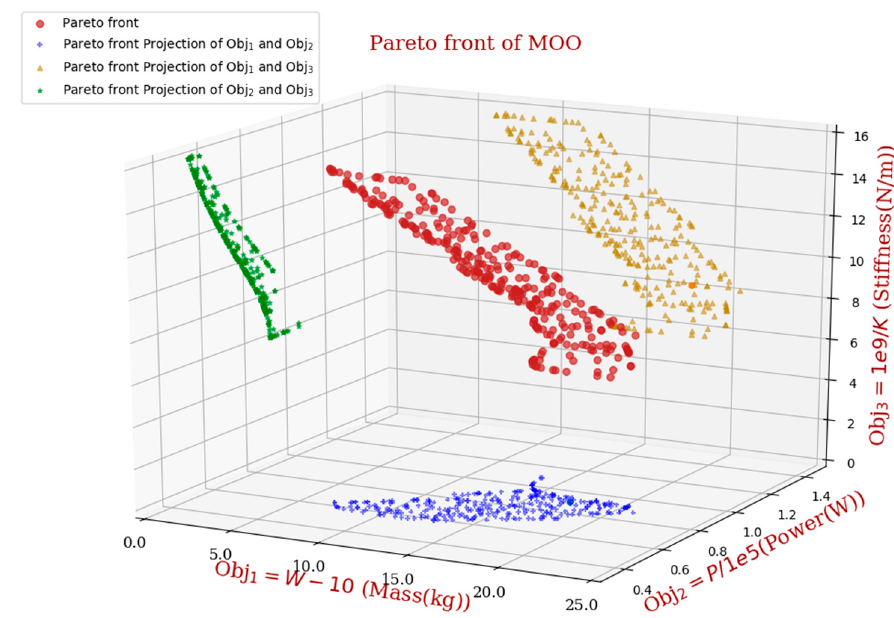
Figure 6. The Pareto front of optimization results of EHA.